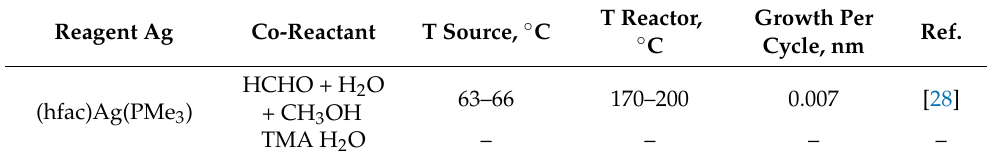
Table 1. Precursors for the synthesis of AgNPs by the ALD